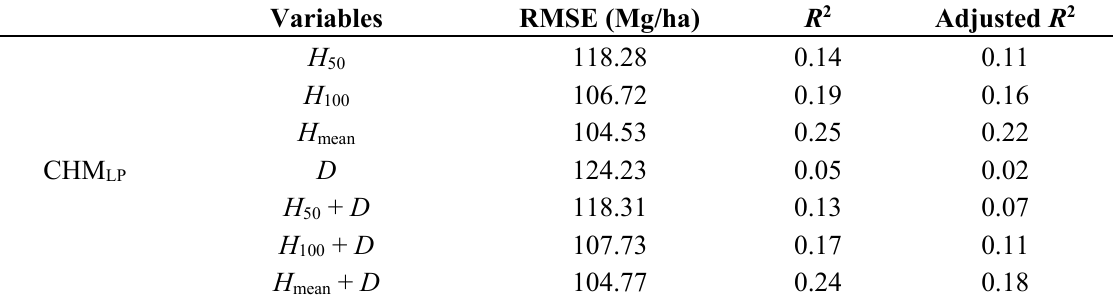
Table 4. Results of estimation models each of canopy height model using CHM LP and CHM LL .